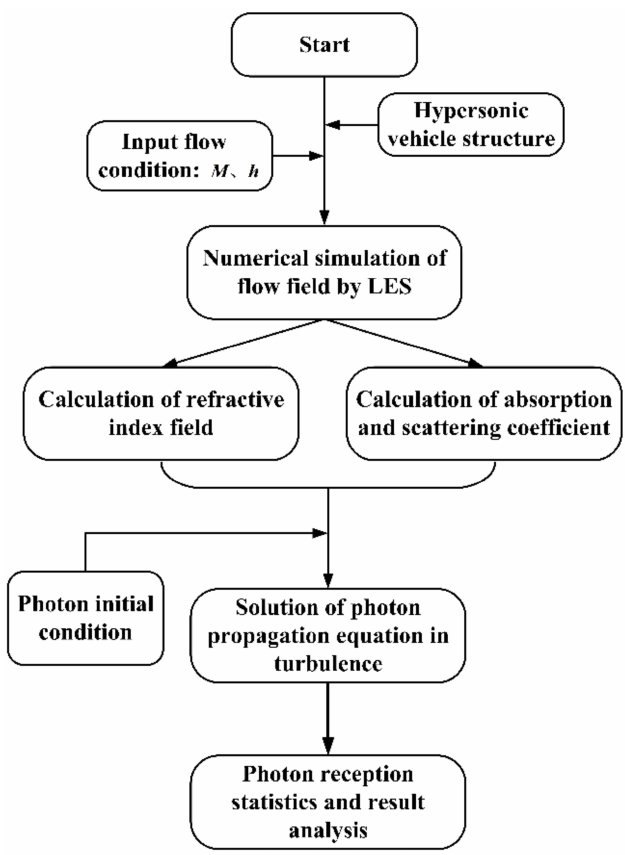
Figure 5. Operation process diagram of